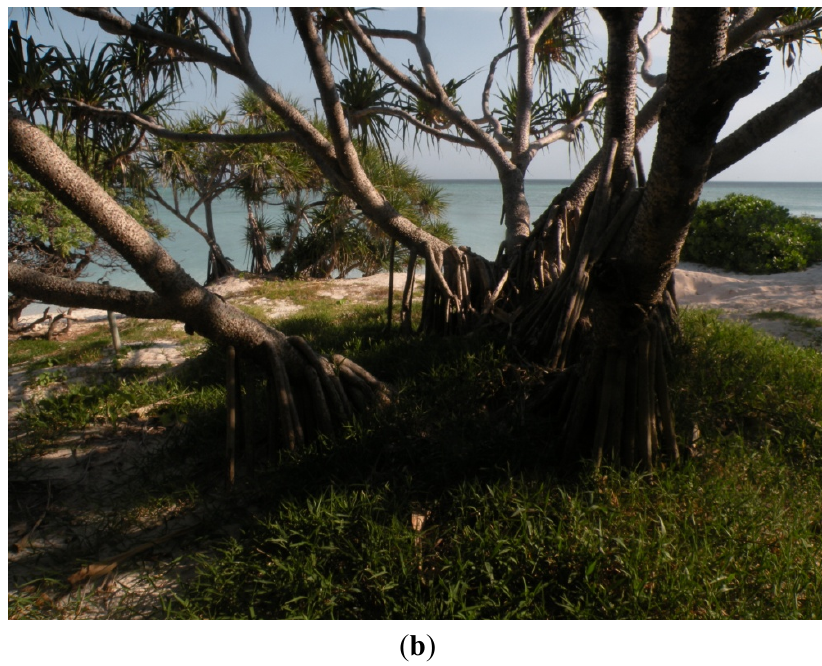
Figure S3. Two views of island edge forests (CAEQ/ARAR), which allow much greater light penetration, understorey plant cover, and tree diversity. ( a ) depicts field measures among predominantly Argusia argentea cover; ( b ) shows Pandanus heronensis .